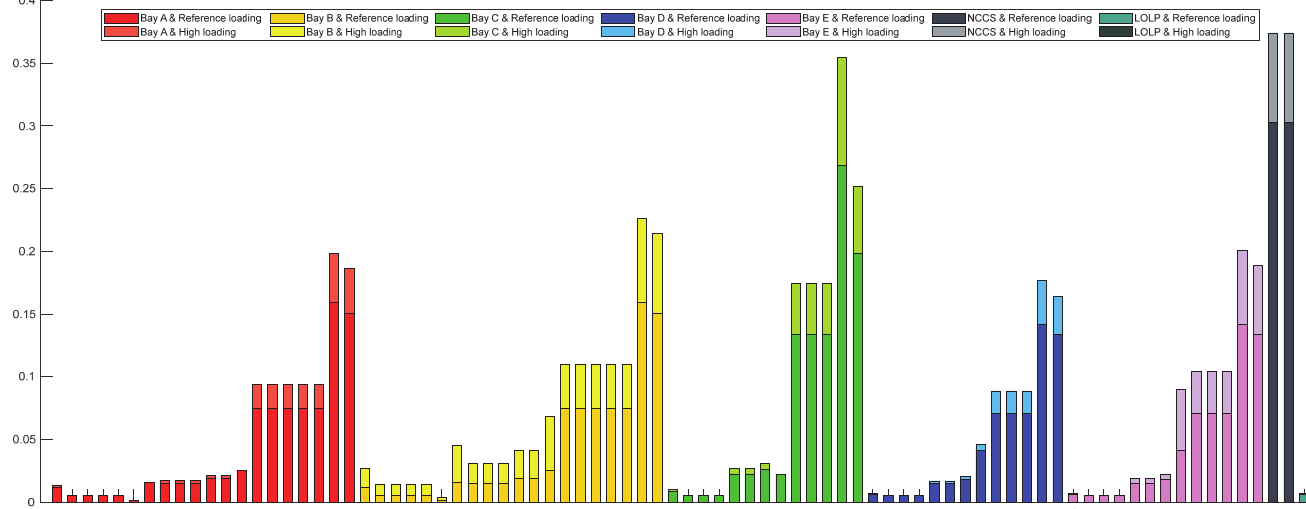
Figure 7. Failure probability under high and low loading rates.